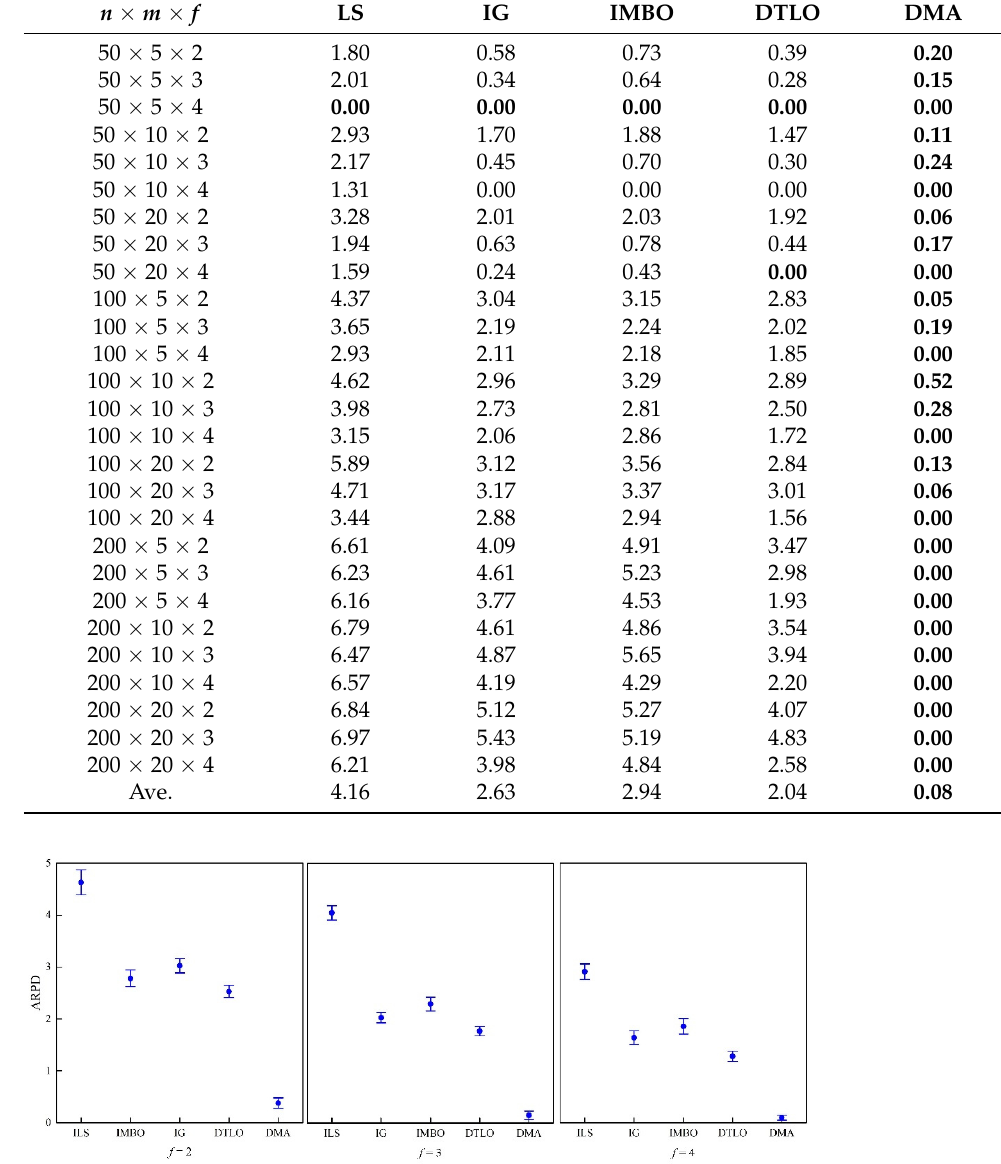
Figure 9. Mean plot with 95% confidence interval of the compared algorithms on different scenarios.